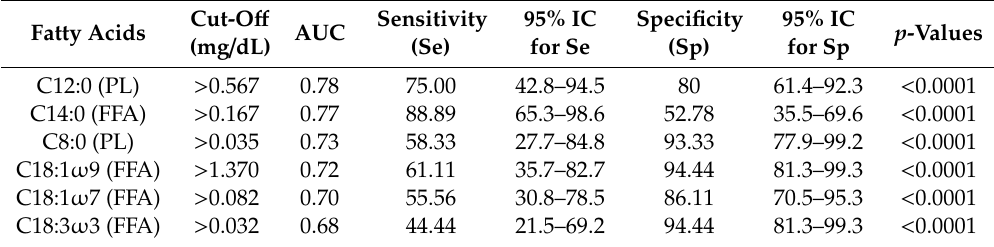
Table 4. Results of the ROC analysis of the predictive fatty acids (FAs) on the basis of NEFA values (greater than 0.56 mEq /